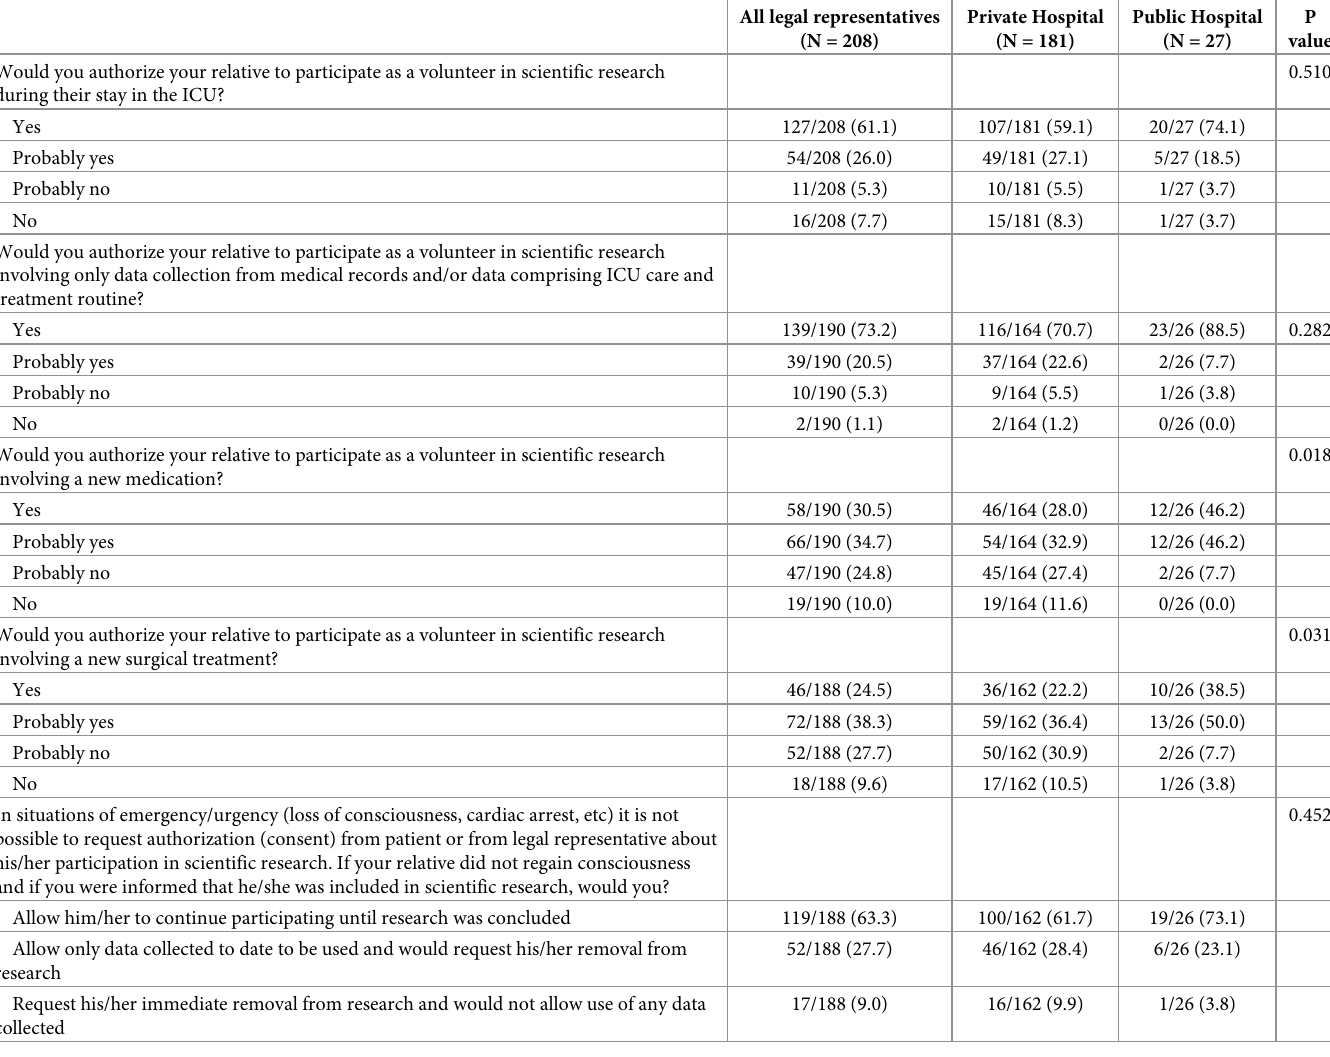
Table 4. Legal representatives’ answers to survey accordingly to the type of hospital. Data presented n º /total (%) #